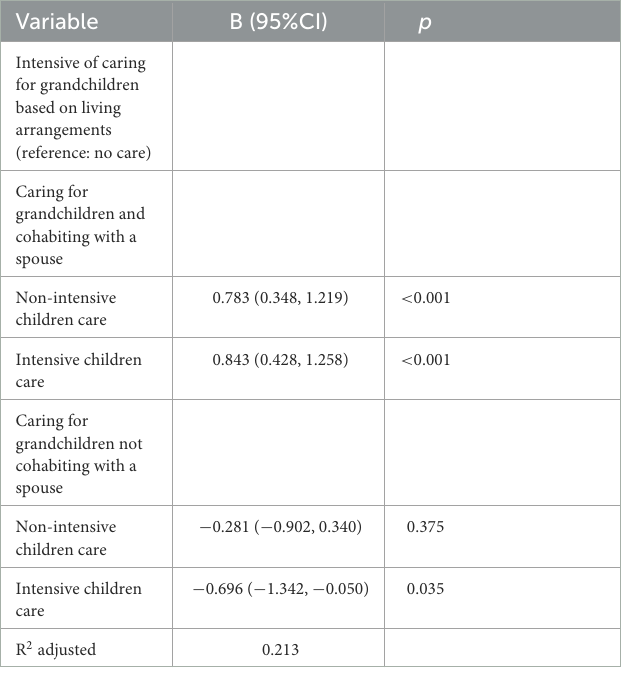
TABLE 3 Regression results of the intensity of caring for grandchildren based on living arrangements and cognitive function. Variable B (95%CI) p